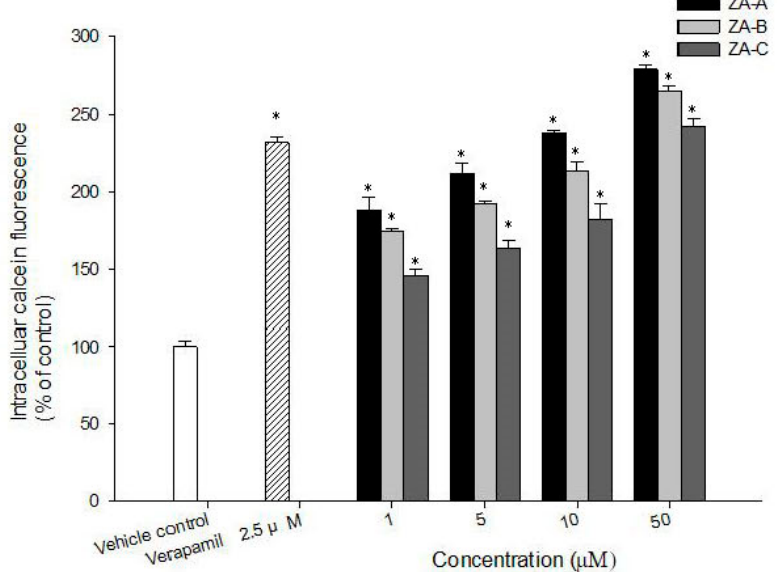
Figure 6. The concentration-dependent inhibitory effects of zhankuic acids (ZAs) A, B, C on P-gp in ABCB1 / Flp-In TM -293 cells. * denotes p < 0.05 compared with the intracellular calcein fluorescence in control group.